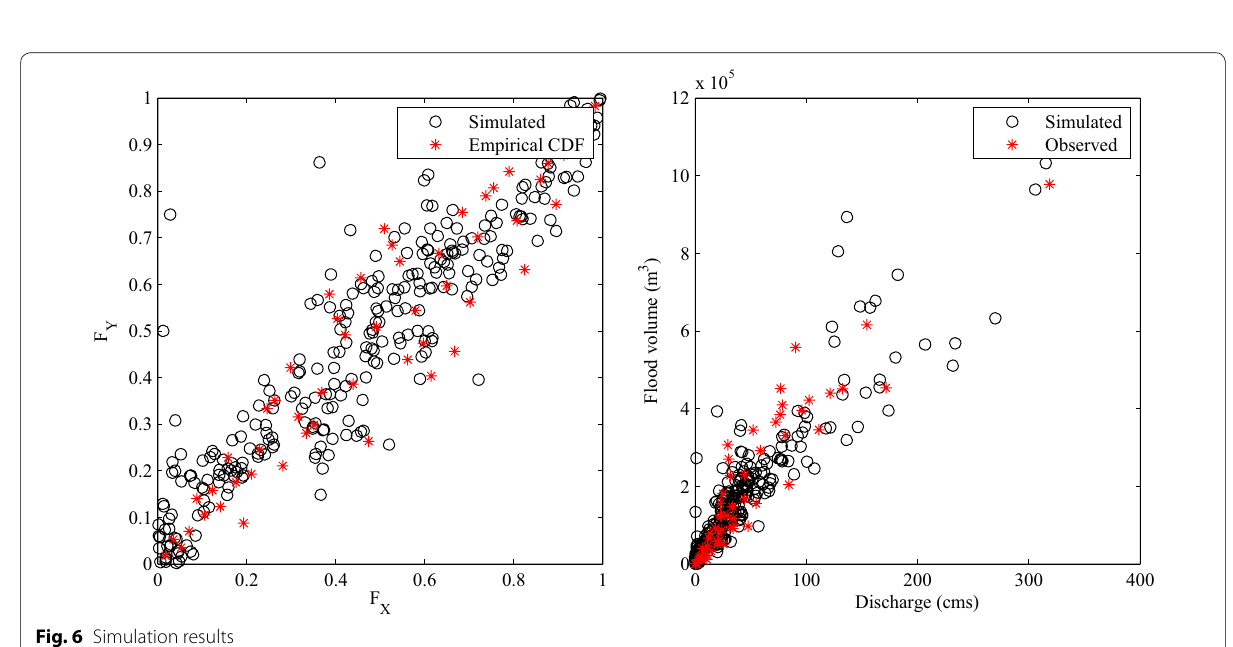
Fig. 6 Simulation